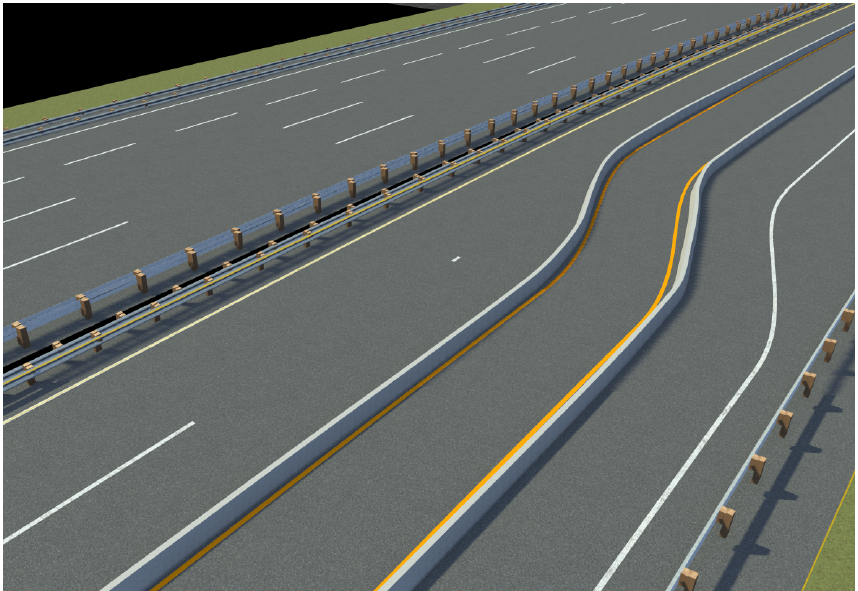
Figure 9. Altered virtual environment, which includes a construction zone typical lane